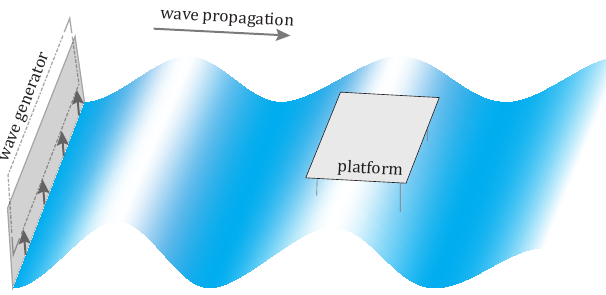
Figure 1. A simplistic view of the model basin. The platform is placed at a distance from the wave generator (on the left) and parallel to the wave propagation